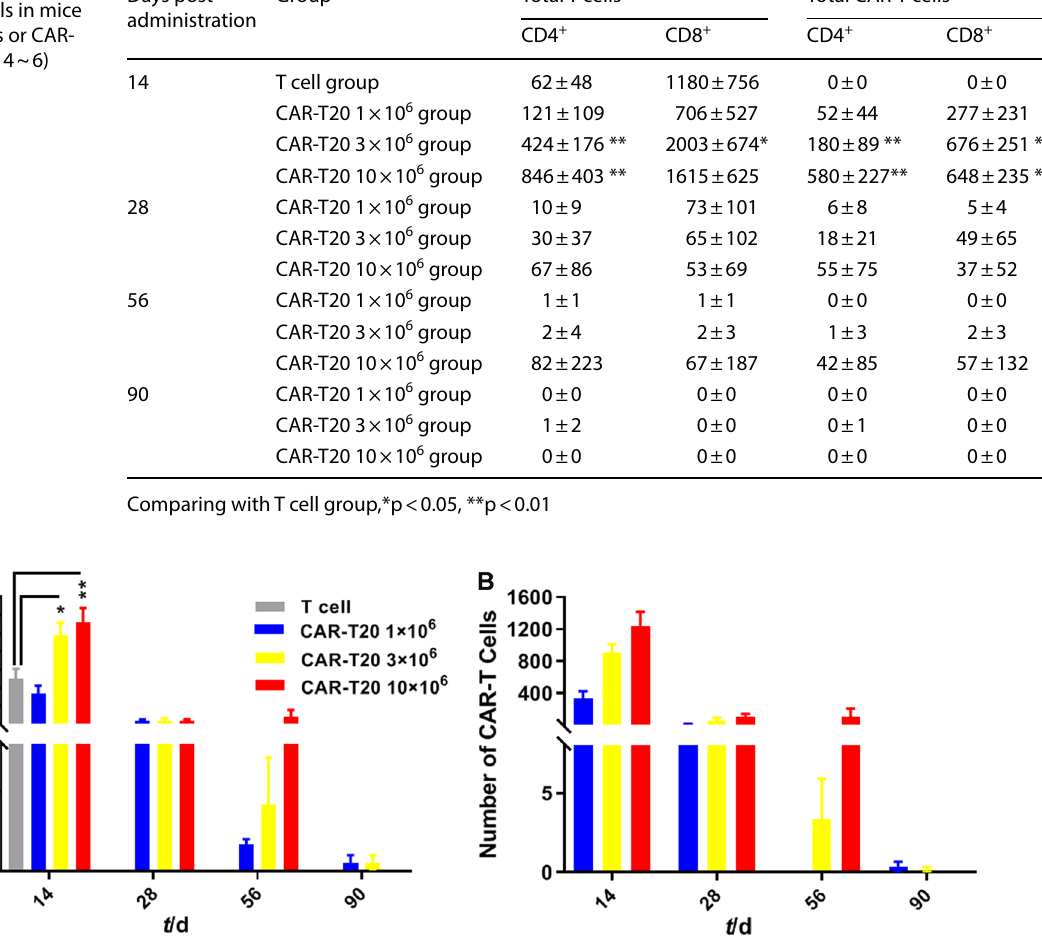
Table 2 Number of human T cell and CAR-T cells in mice administered T cells or CAR- T20 (mean ± SD, n = 4 ~ 6)